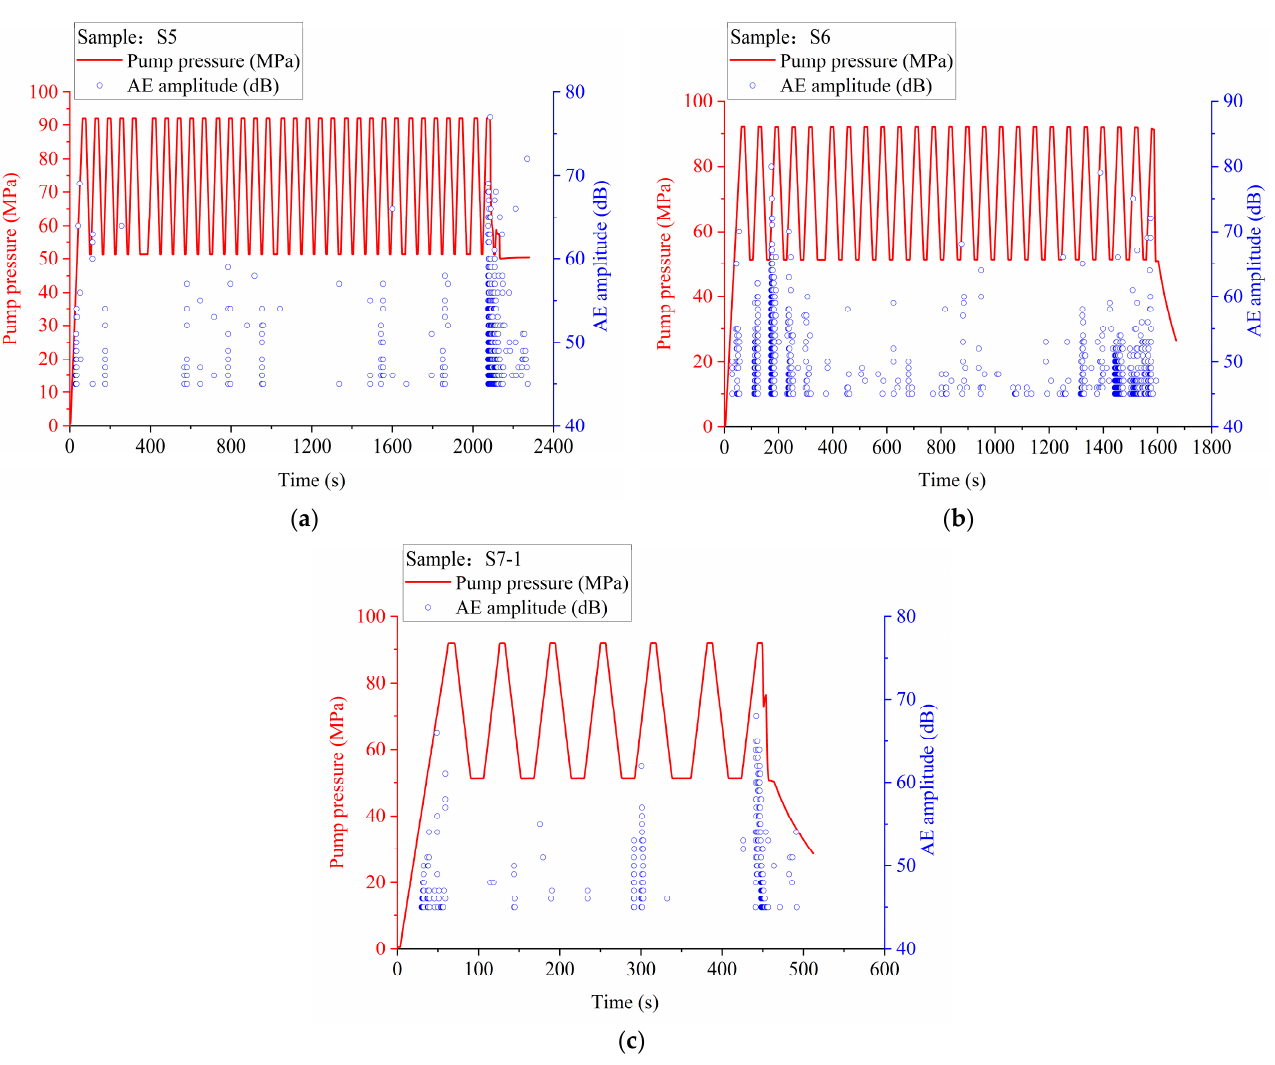
Figure 7. The relationship between pump pressure, AE amplitude, and injection time of samples: